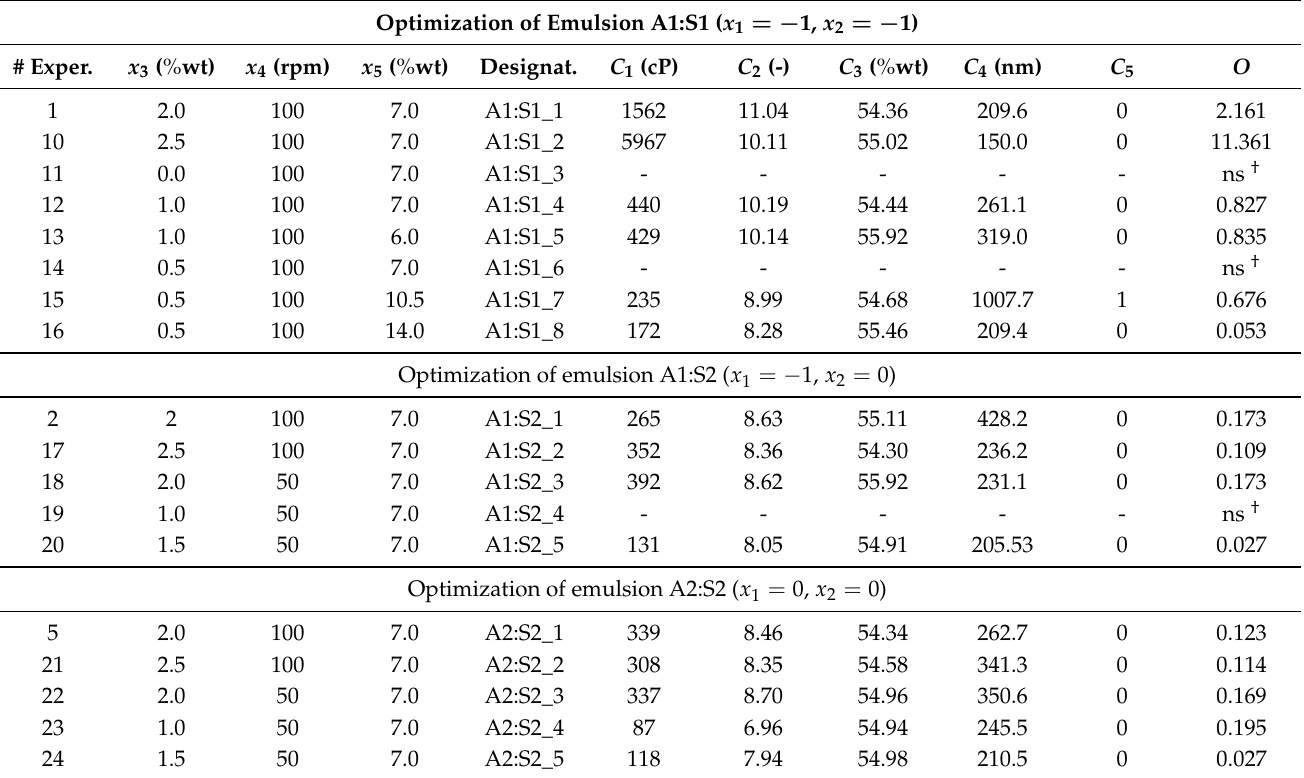
Table 6. Results of the experimental design in the optimization of secondary factors stage.